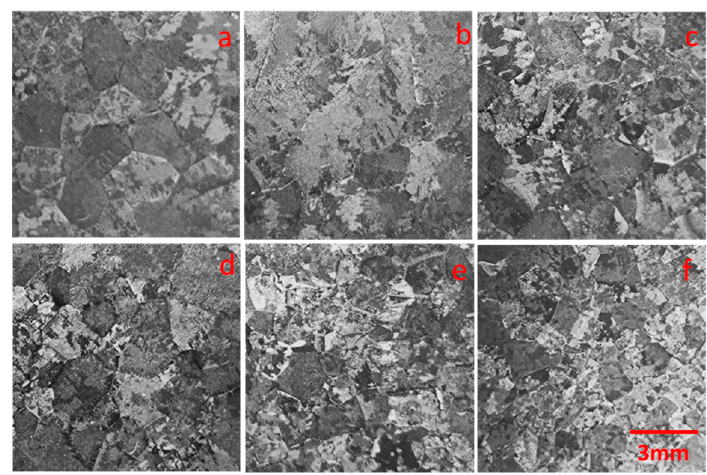
Figure 7. Effect of Fe content on grain size: ( a ) 0Fe, ( b ) 0.1Fe, ( c ) 0.3Fe, ( d ) 0.5Fe, ( e ) 0.7Fe, ( f ) 0.9Fe.